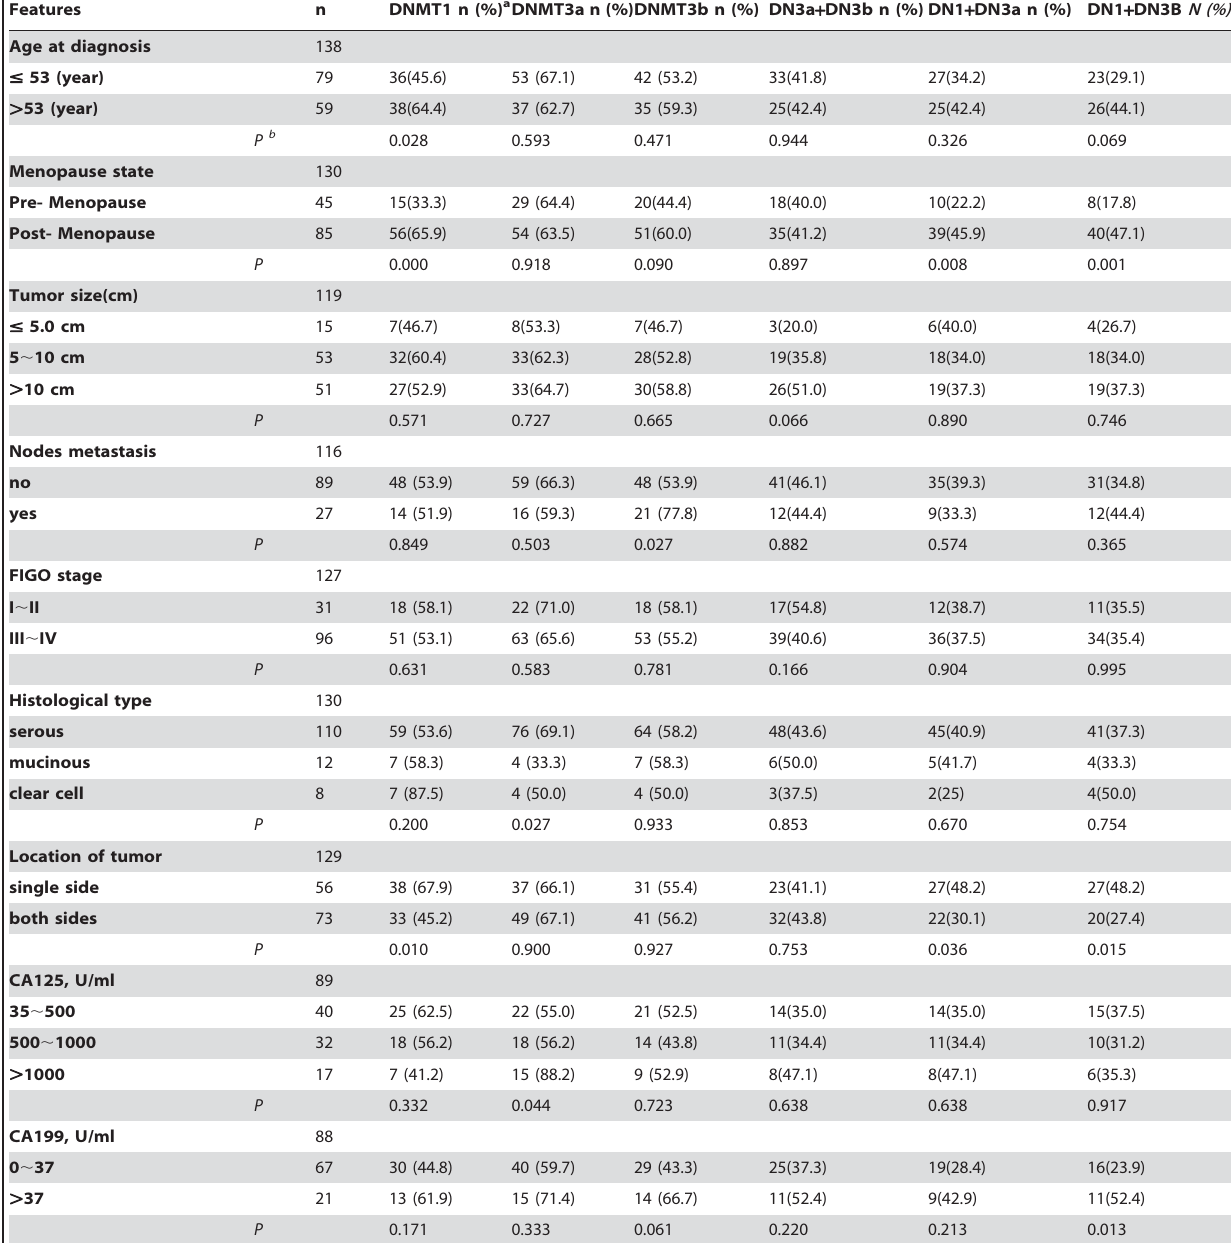
Table 4. Correlation between DNMTs expression and clinicopathological features of sporadic ovarian cancer patients.